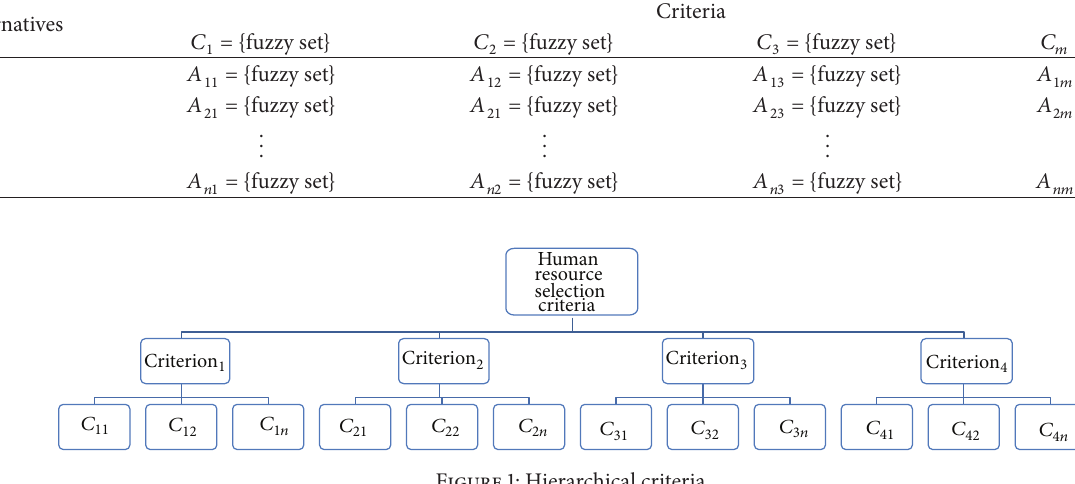
Figure 1: Hierarchical criteria.